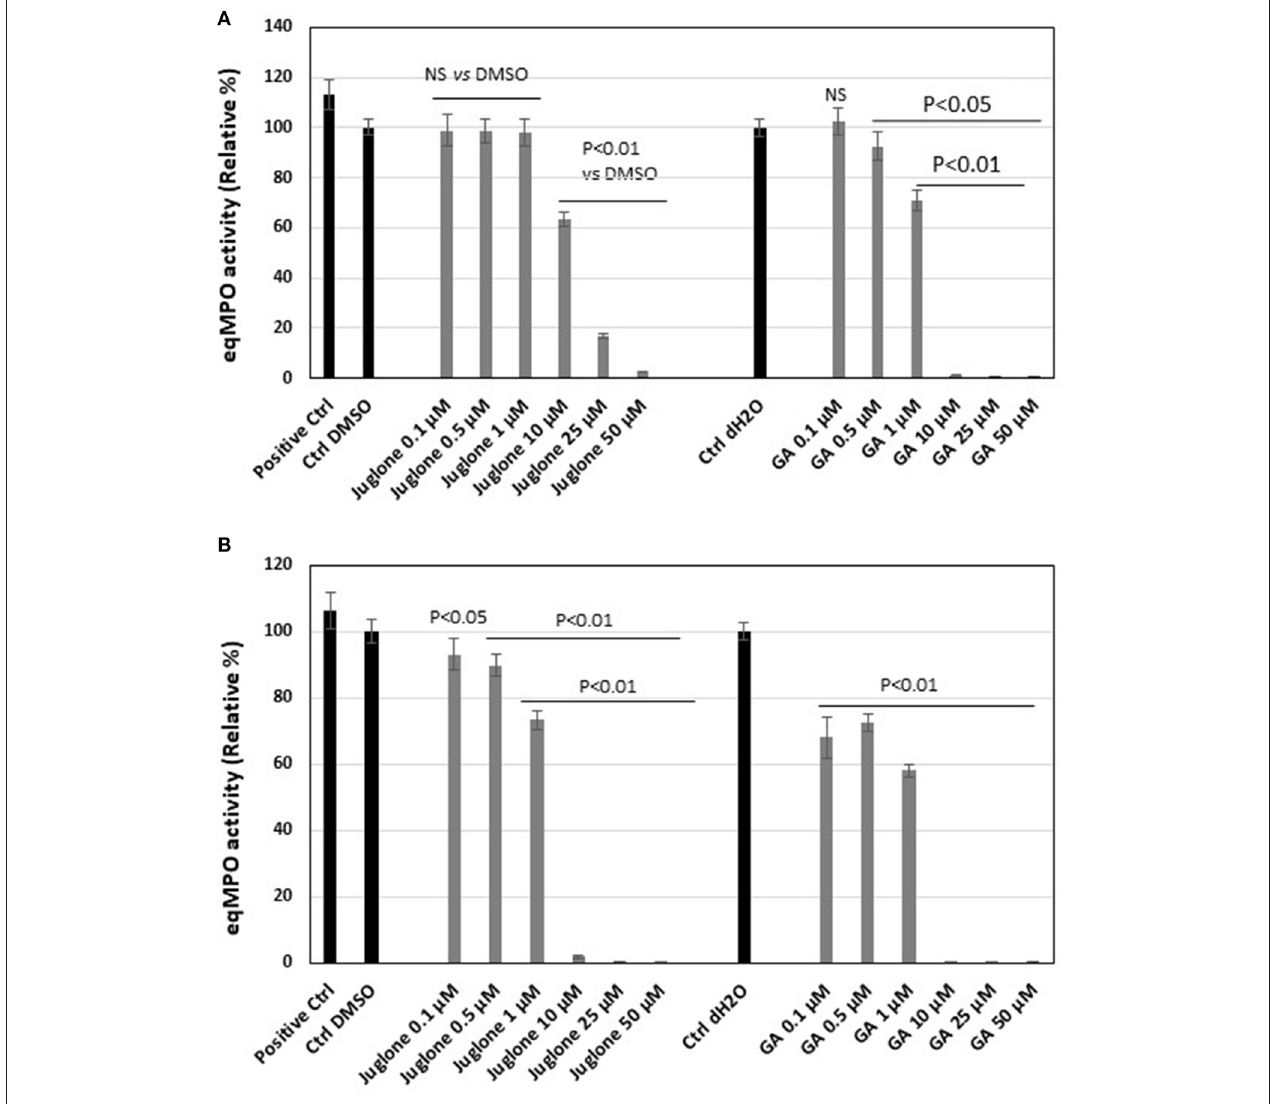
FIGURE 4 | Equine myeloperoxidase (MPO) activity and effect of increasing concentrations of juglone vs. gallic acid taken as the reference inhibitor. (A) Activity of MPO measured by a classical enzymatic assay. (B) Activity of MPO measured by the specific immunological extraction followed by enzymatic detection (SIEFED) assay. The results are the mean ± SD ( n = 4). Positive Ctrl , PBS with MPO alone; Ctrl DMSO and Ctrl dH 2 O contained MPO + 1% dimethyl sulfoxide (DMSO) or distilled H 2 O (dH 2 O), vehicles of juglone and gallic acid, respectively. Values of p are vs. DMSO or dH 2 O control taken as 100% activity of